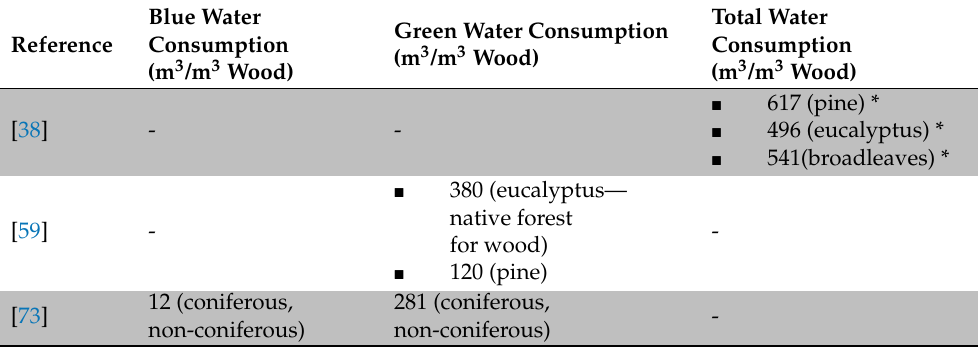
Figure 9. Sustainability and impact assessment methods under WFN and LCA-based WF approaches applied to forest and orchard trees case studies and mixed approaches and their temporal distribution. Table 2. WF results obtained for forest trees at the accounting or inventory phase for case studies and mixed approaches that reported water volume per m 3 of wood